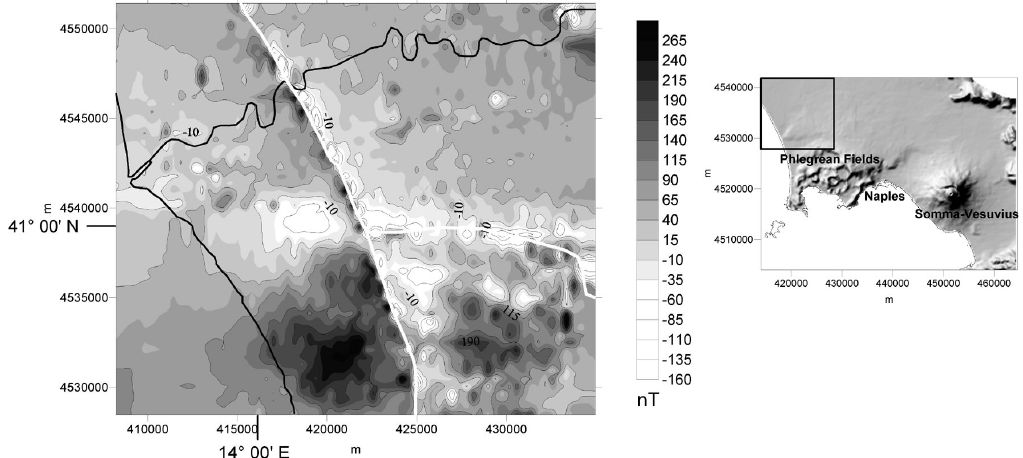
Fig. 3. Aeromagnetic field measured at 100 m above the surface relative to a survey carried out in Northern Phlegrean Fields in 1999-2000. The white lines show the railway line, the black line shows the coastline (from Paoletti et al. ,